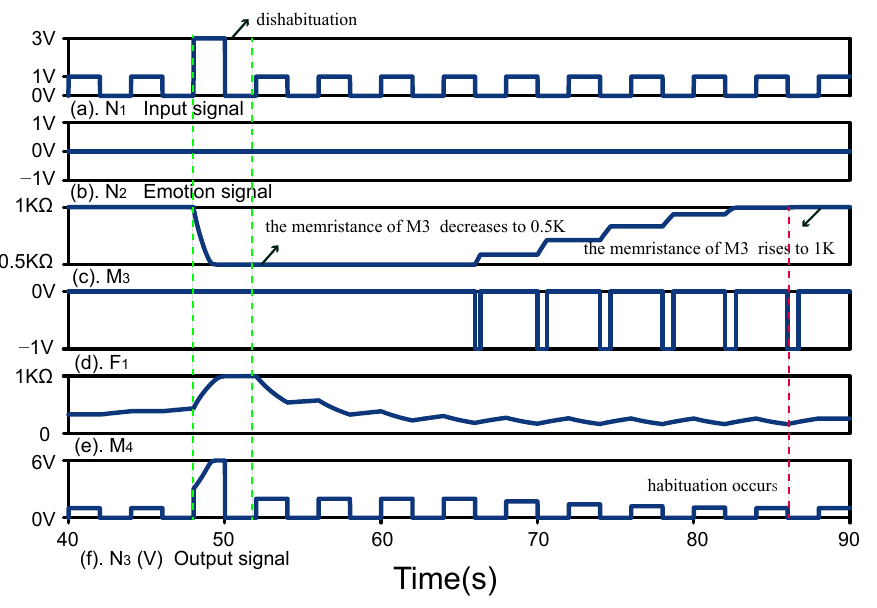
Figure 11. Dishabituation . ( a ) Input signal. ( b ) Emotion signal. ( c ) Memristance of M 3 . ( d ) Feedback signal F 1 . ( e ) Memristance of M 4 . ( f ) Output signal N 3